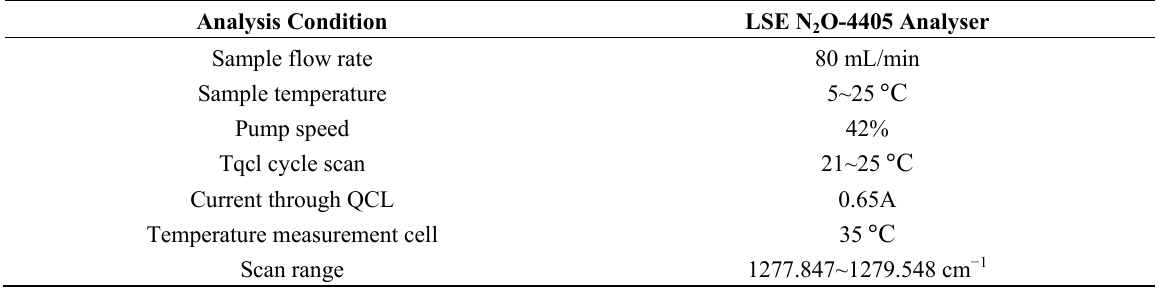
O-4405 Analyzer 2